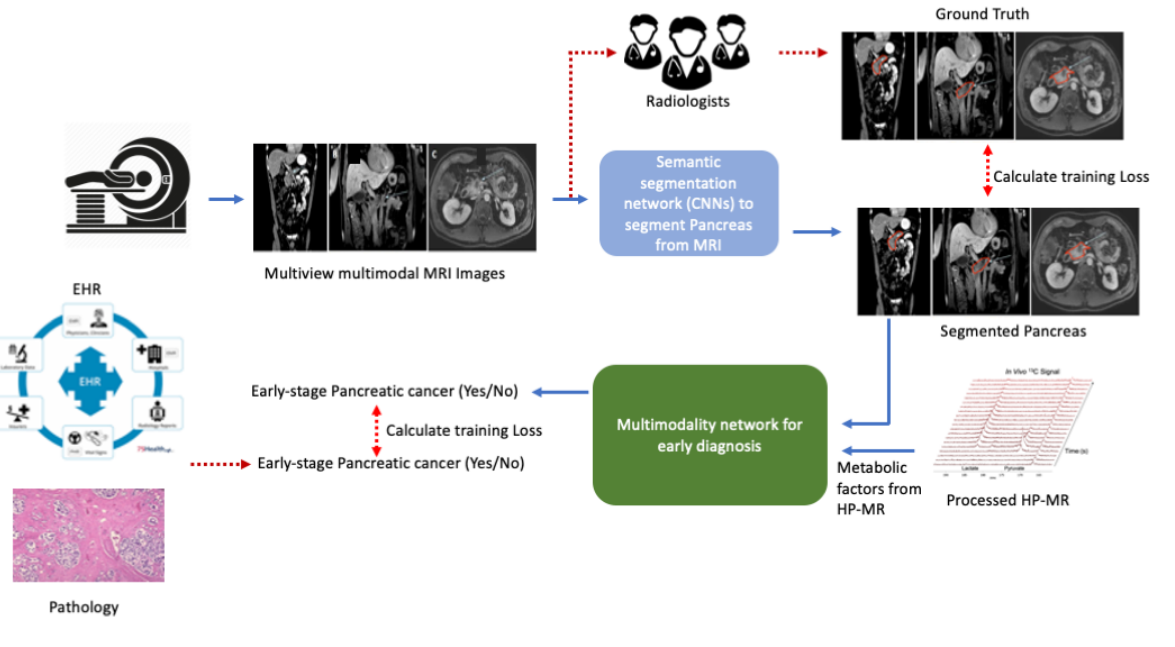
Poor signal-to-noise ratio and contrast-to-noise ratio.